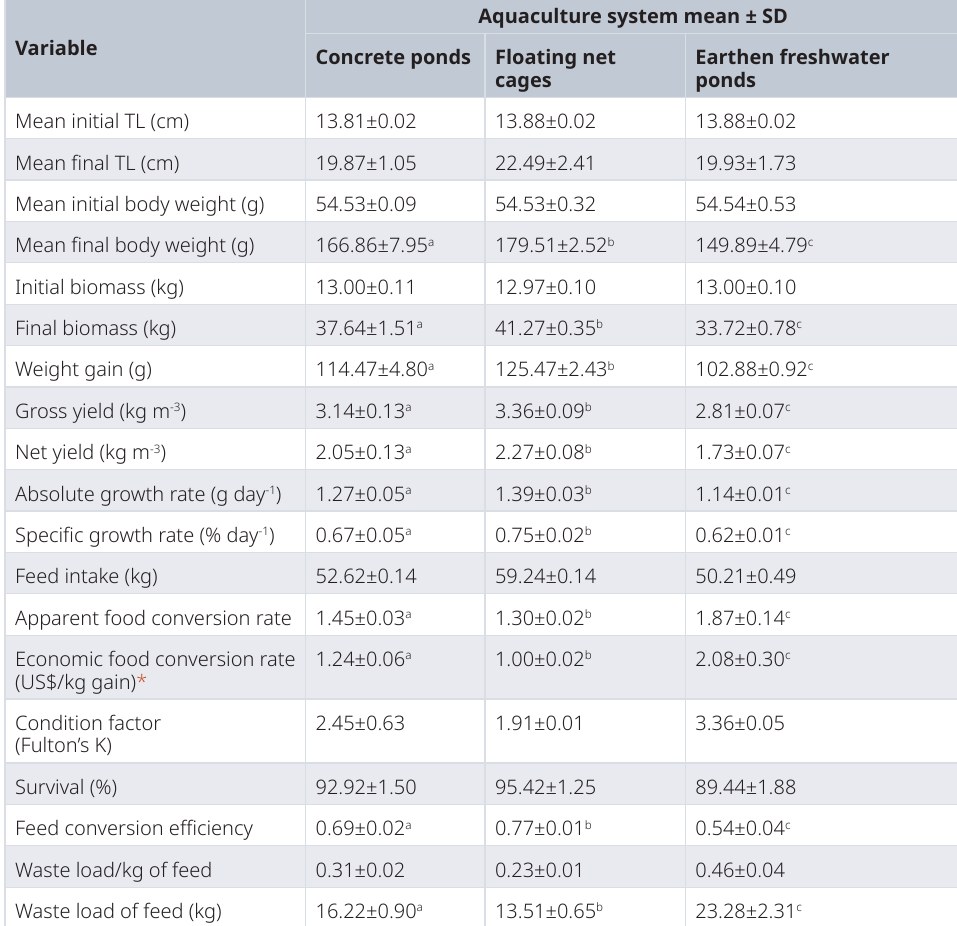
Table 1. Growth performance of gurami sago in three aquaculture systems over 90